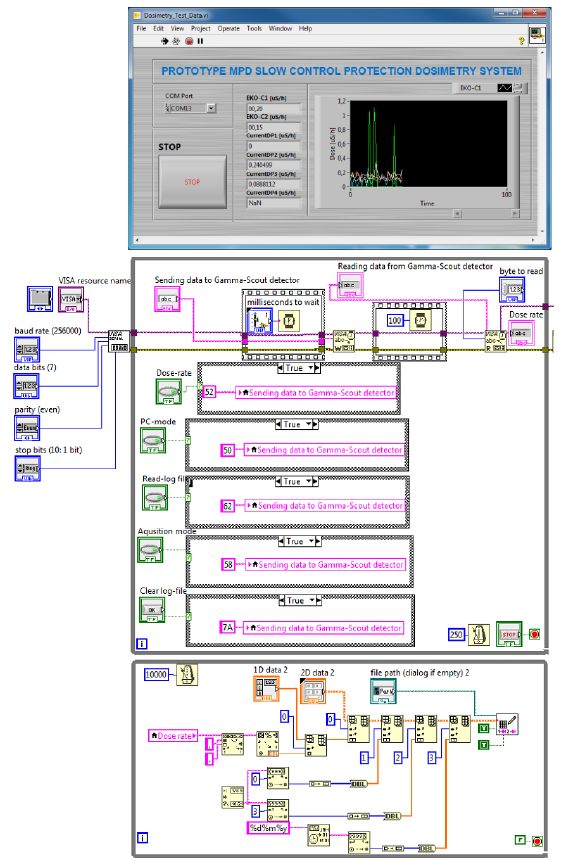
Figure 4. Up: Example screen from LabView control program. Bottom: Part of the LabView program block scheme for the Gamma Scout detectors.